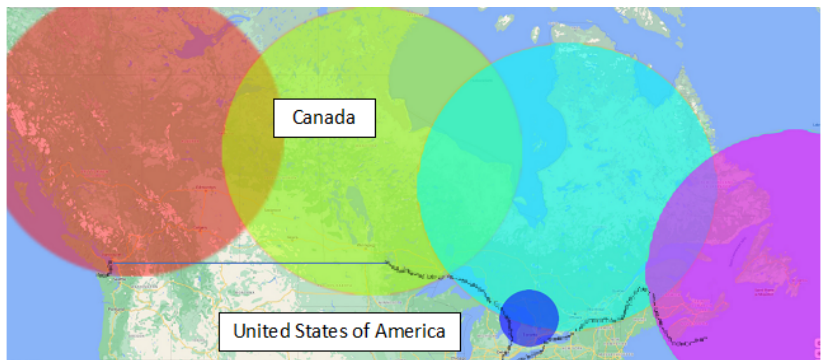
Figure 2. A map of where Twitter users were located. Tweets from outside of Canada (ie, those from the United States) were